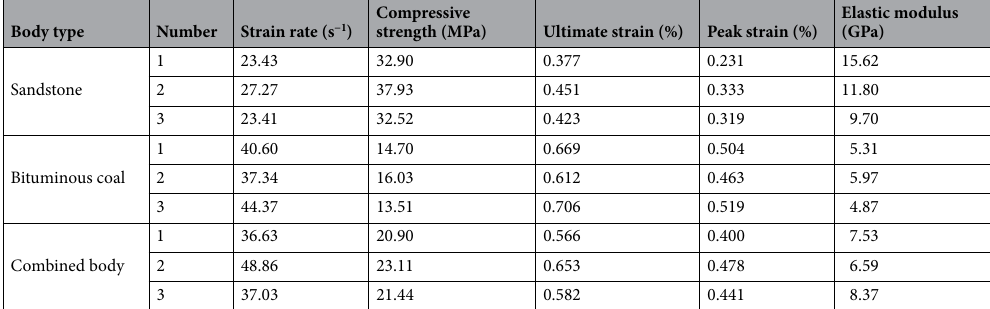
Table 3. Dynamic mechanical parameters of coal, rock, and combined bodies.